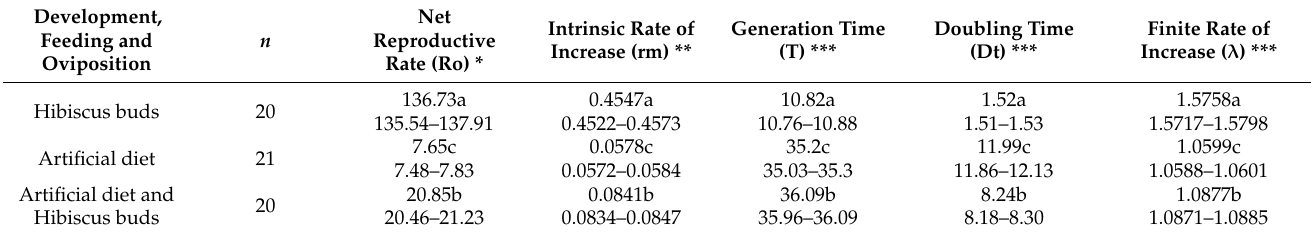
Table 4. Life table parameters and 95% confidence intervals for the hibiscus bud weevil ( Anthonomus testaceosquamosus ) when it developed, fed, and reproduced solely on hibiscus buds, on the artificial boll worm diet, or when it developed on the diet and reproduced on hibiscus buds. Within each column different letters indicate significant differences (Tukey, p <